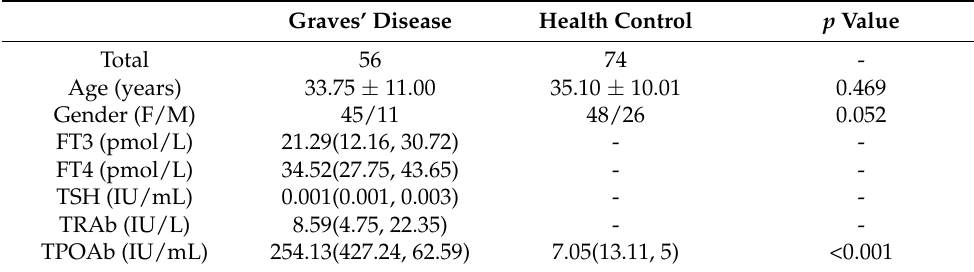
Table 1. The clinical characteristics of the study subjects. Graves’